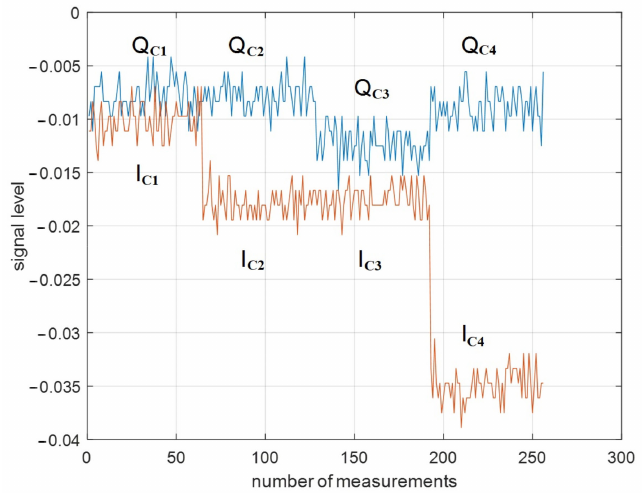
Figure 7. Unprocessed circularly polarized target signature of circular polarization (truck, profile angle 45 ◦ ): I C1 , Q C1 —left-hand circular transmission and right-hand circular reception, respec- tively; I C2 , Q C2 —right-hand circular transmission and right-hand circular reception, respectively; I C3 , Q C3 —right-hand transmission and left-hand circular reception, respectively; I C4 , Q C4 —left- hand circular transmission and left-hand circular reception,